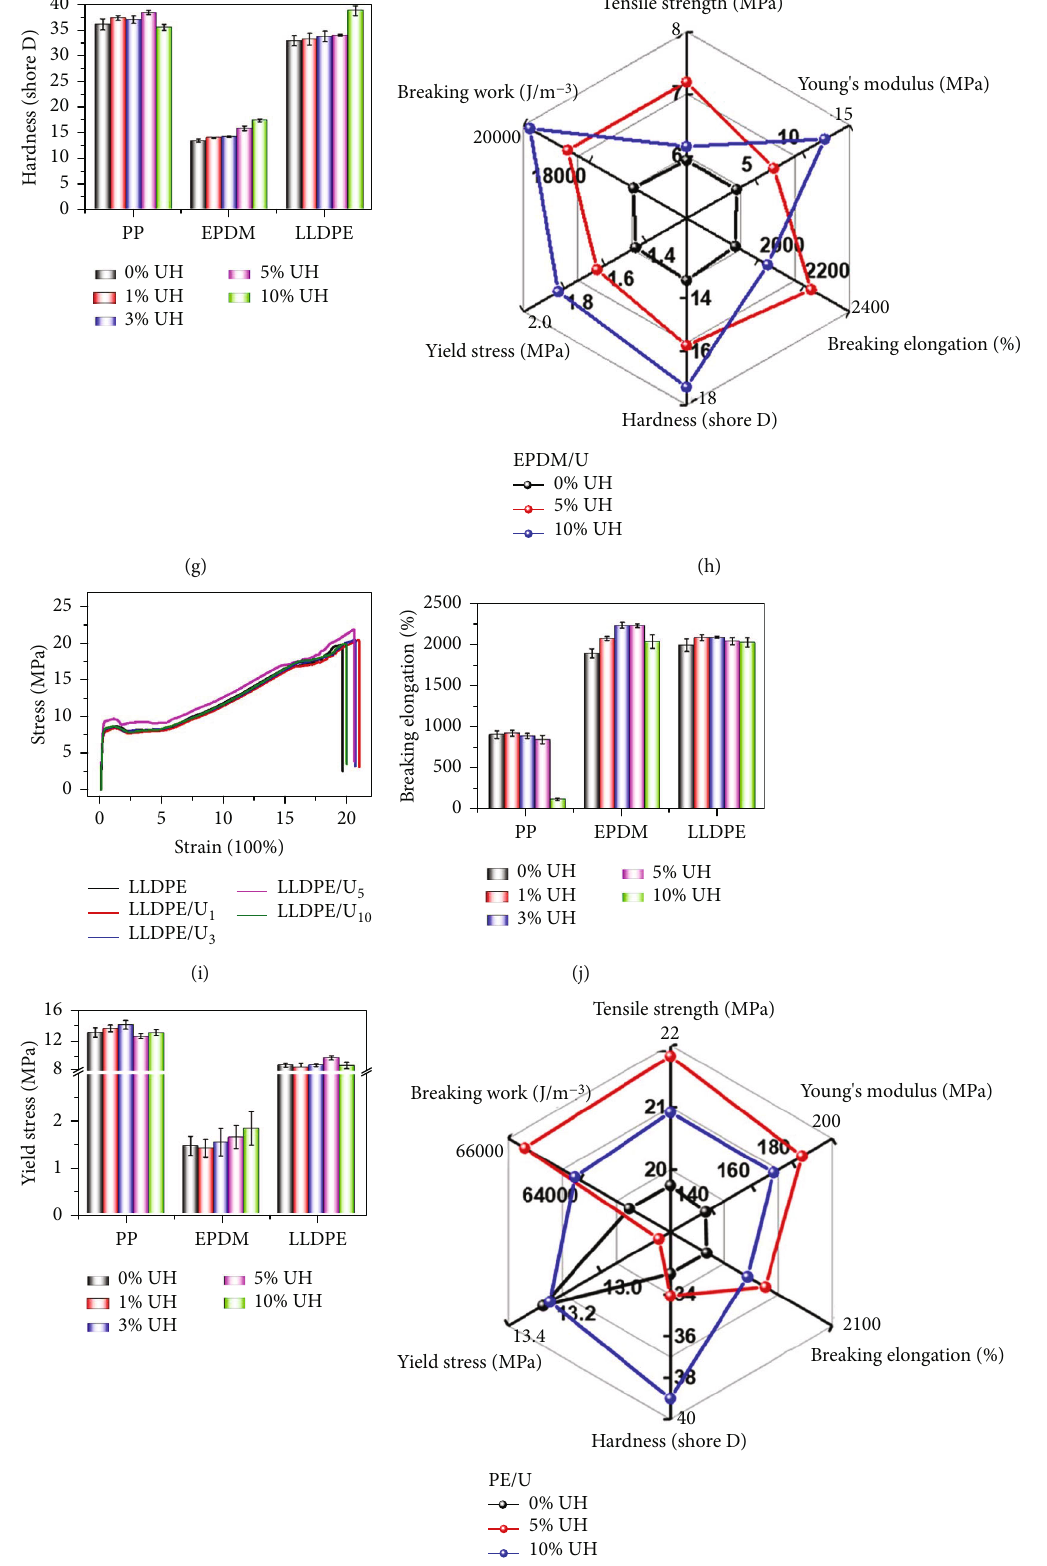
Figure 10: (a, e, i) Typical stress-strain curves of three samples, (b) tensile strength, (c) breaking work, (f) Young ’ s modulus, (g) hardness, (j) breaking elongation, (k) yield stress, (d) radar chart of PP/U blend, (h) radar chart of EPDM/U blend, and (l) radar chart of LLDPE/U